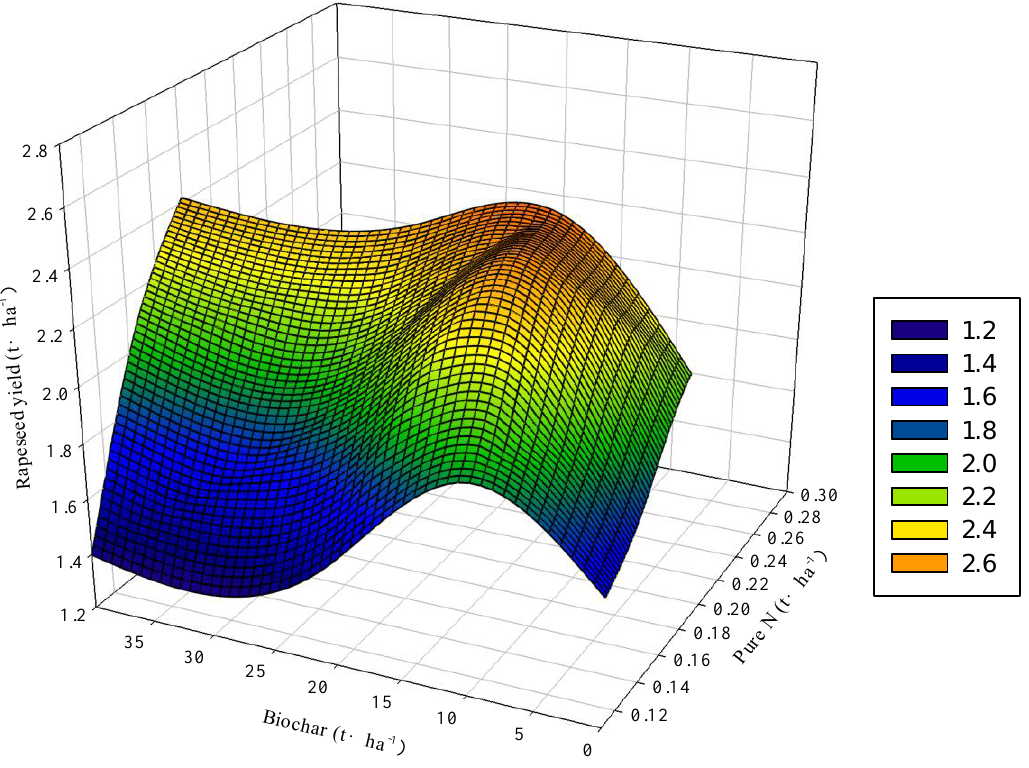
Figure 4. The relationship between rapeseed yield and application rates of biochar and N fertilizer in a 3D color map surface image.